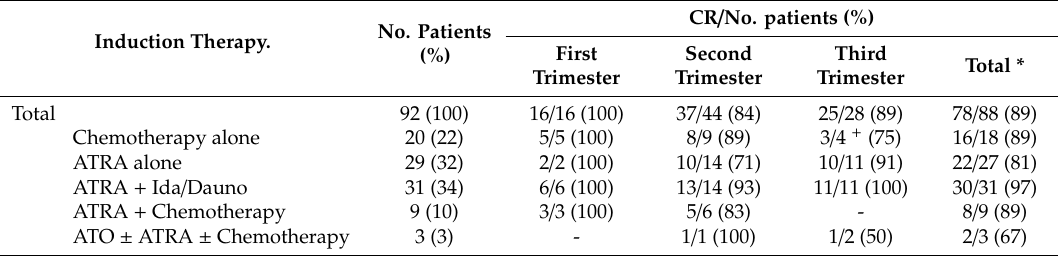
Table 3. Induction therapy and results in pregnant women with APL by gestational age at diagnosis. Induction